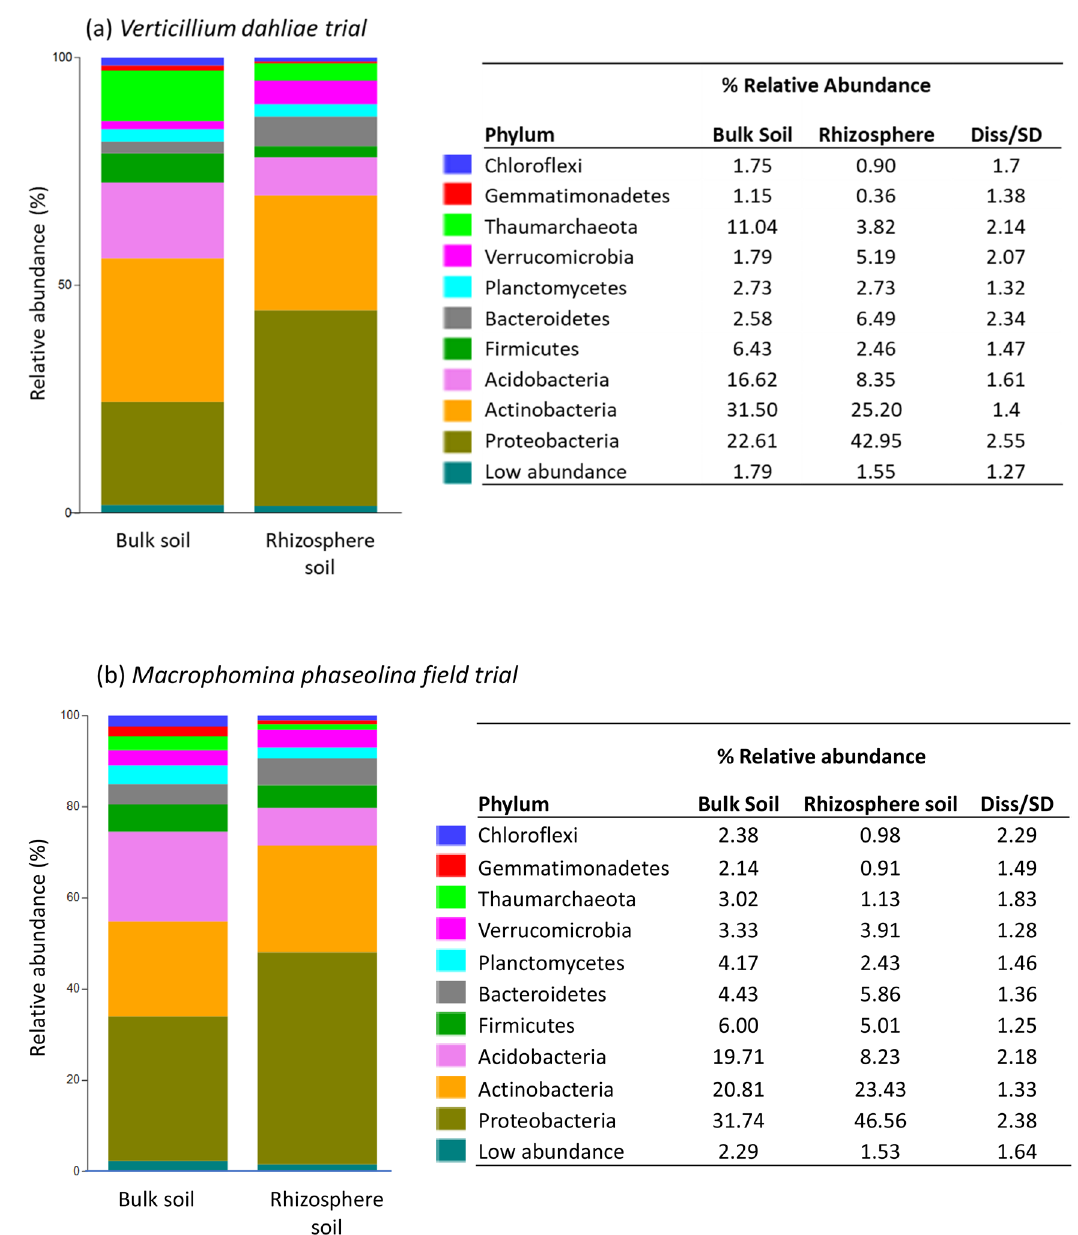
Figure 2. Differences in the average relative abundance of the main archaeal and bacterial phyla in the bulk and rhizosphere soil samples collected from the pathogen trials infested with Verticillium dahliae ( a ) and inoculated with Macrophomina phaseolina ( b ). Phyla representing < 1% of the average relative abundance were grouped into ‘low